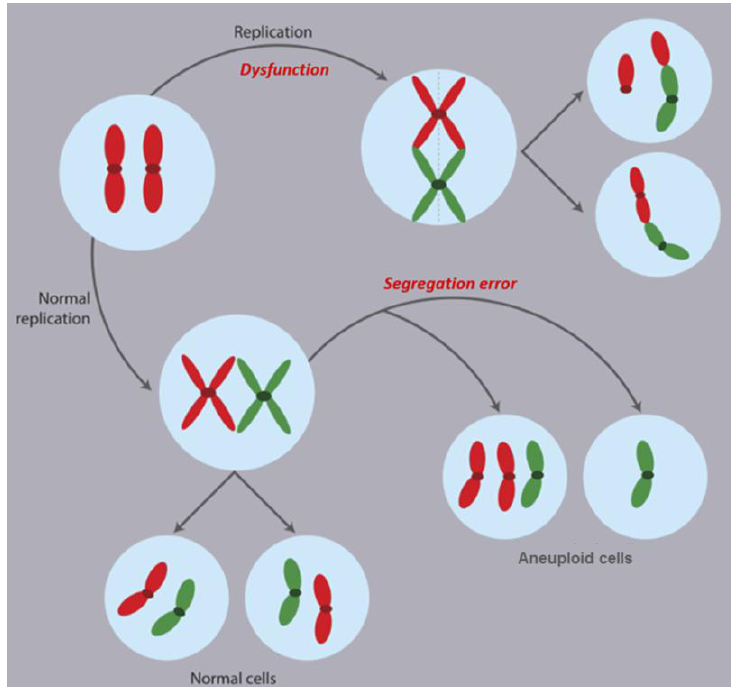
Figure 2. Numerical and structural CIN arise during mitotic chromosome segregation errors. Dysfunctional chromosome duplication or segregation during mitosis can conduce to whole chromosome gains and losses (numerical CIN) and/or alterations in the structure of chromosomes (structural CIN) including translocations, deletions, and derivative chromosome, among other. Both numerical and structural alterations predispose chromosomes to subsequent chromosomal alterations, thereby increasing CIN.